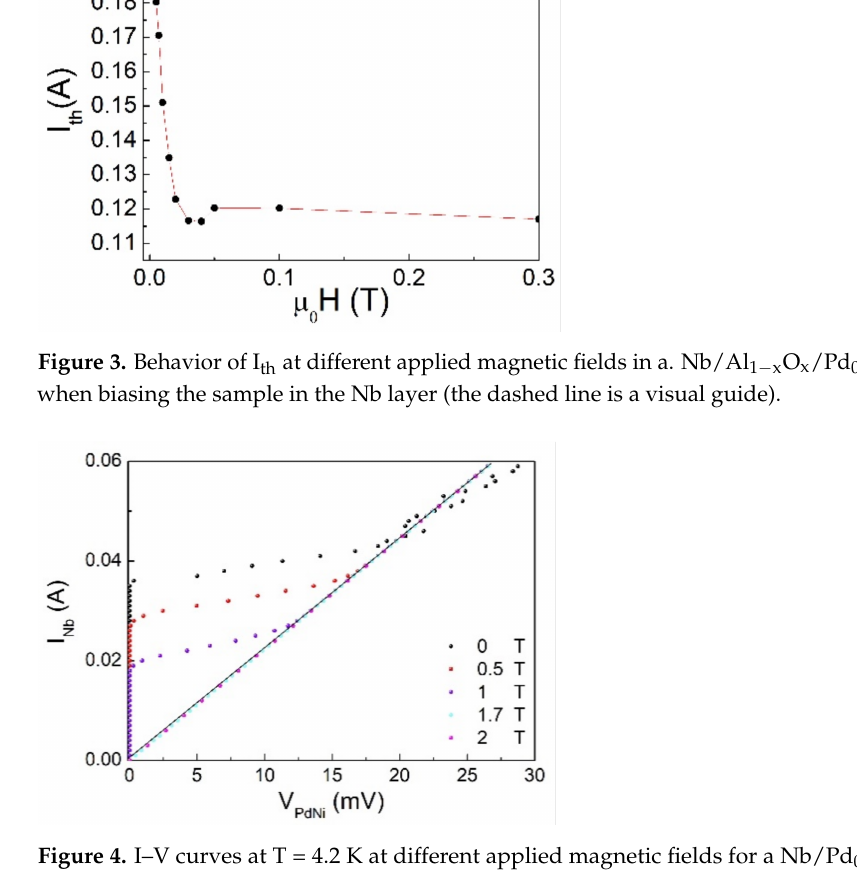
Figure 4. I–V curves at T = 4.2 K at different applied magnetic fields for a Nb/Pd 0.84 Ni 0.16 bilayer with current sent in Nb.